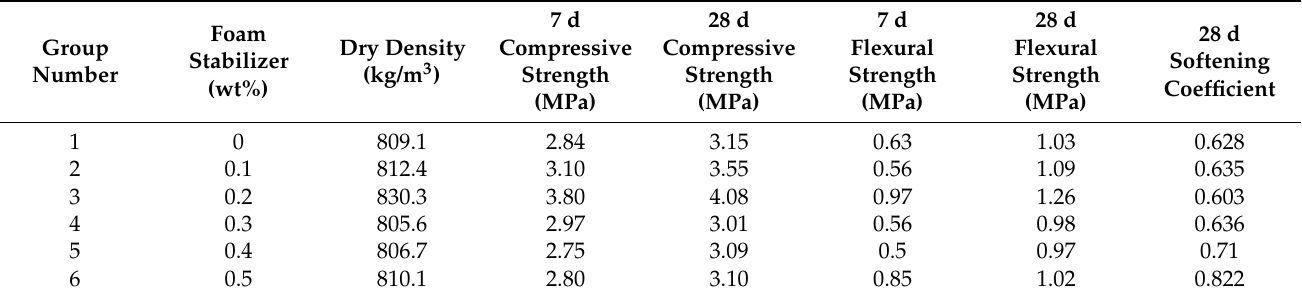
Table 8. Optimization results of specimens with different foam stabilizer